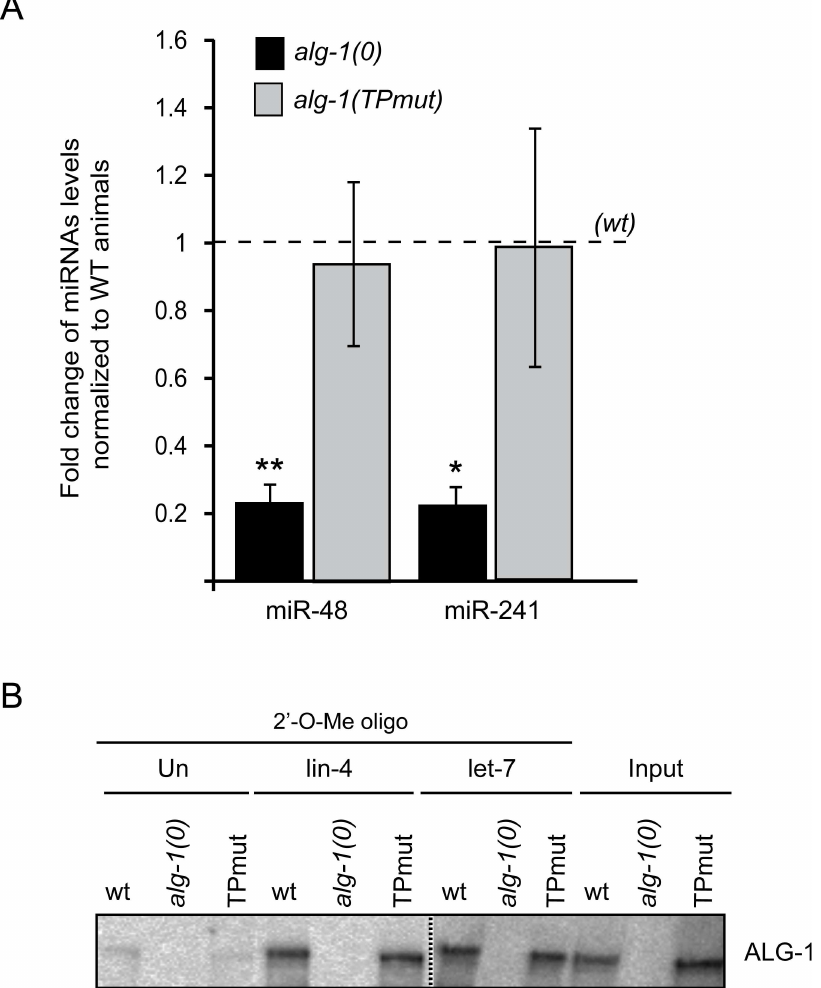
Fig 2. The loss of function of ALG-1 tryptophan-binding pockets mutant occurs downstream of the biogenesis of microRNA. (A) Quantification of microRNAexpression . The levels of miR-48 and miR-241 were measuredby quantitative RT-PCR at mid L3 stage from alg-1TPmut and alg-1(0) whole worm RNA extracts, and were normalized to alg-1(wt) . Small nucleolarRNA sn2841was used as reference. The error bars represent the 95% confidenceintervalfrom three independentexperiments and a Student’stwo-sidedt- test was appliedto obtain p values. * p < 0.05, ** p < 0.005. (B) Western Blot analysis of ALG-1(TPmut) or (wt) associated to lin-4 and let-7 miRISC . Isolation of miRISC was performed using a 2 0 -O-methyl oligonucleotide (2 0 -O-Me oligo) column complementary to lin-4 or let-7 mature microRNA. The extract from transgenic animalswas first pre-incubated with an unrelated2 0 -O-methyl oligonucleotidecolumn (Un) then incubatedwith the indicated2 0 -O-methyl oligonucleotide complementary to lin-4 and let-7 sequences.The purifiedcomplexes were run on to an SDS polyacrylamide gel and blotted with an antibody againstALG-1. The dashed line indicatesthat unrelatedlanes have been removedbetweensamples.